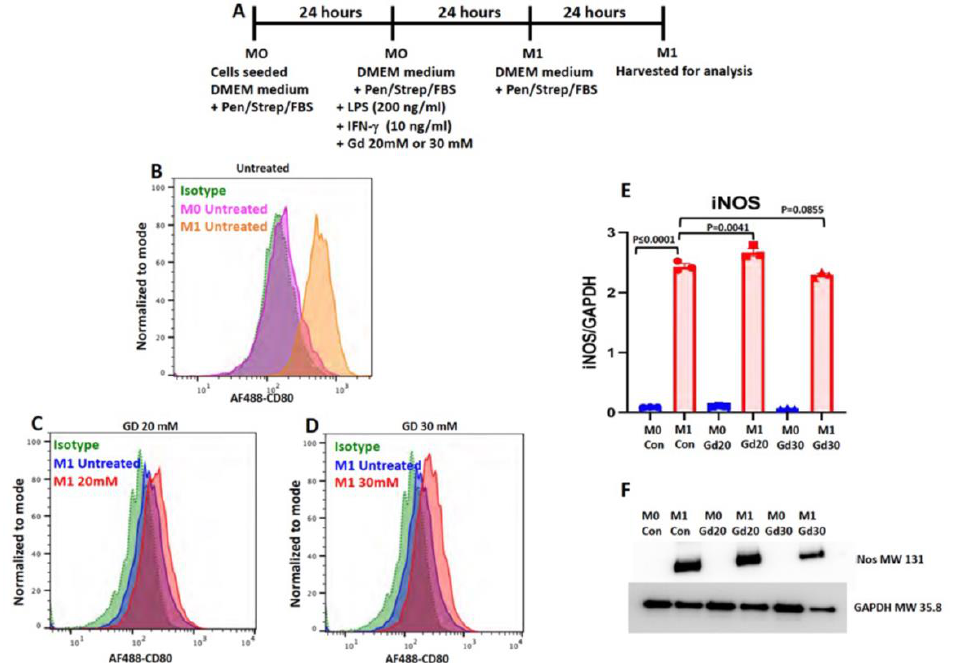
Figure 13. Dotarem upregulated the expression of pro-inflammatory (M1) markers. ( A ) The scheme and timeline of M1 polarization and Dotarem (gadolinium, Gd) treatment. ( B – D ) Flow cytometry analysis of the expression of M1 marker CD80 showed the upregulation of the expression in gadolinium-treated cells. To make the results more accurate by taking into account the differences in the number of living cells between the experimental groups, we normalized the cell count to the percentage mode. ( E , F ) Western blot analysis of M1 marker iNOS expression showed statistically significant upregulation of the expression in gadolinium-treated cells.